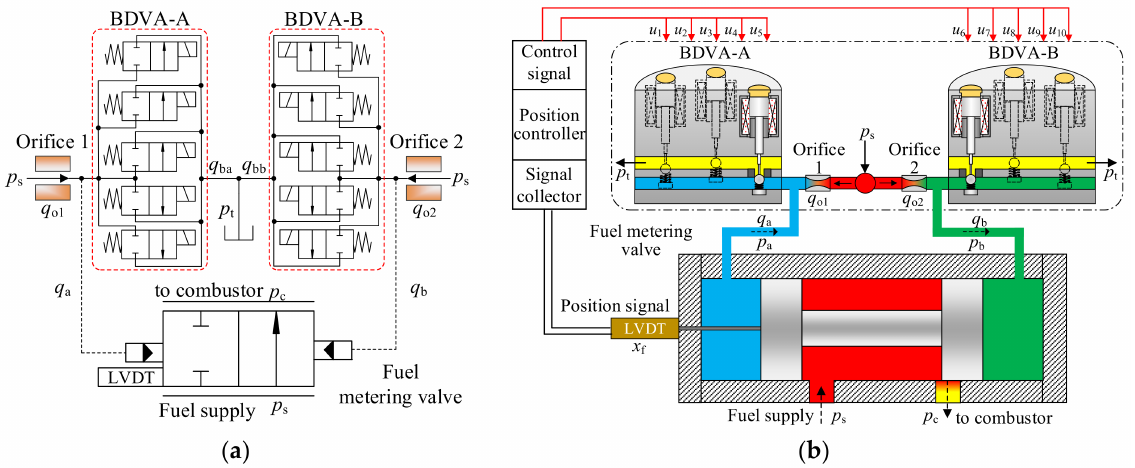
Figure 1. Schematic diagram and structure of the fuel metering valve: ( a ) Schematic diagram; ( b )